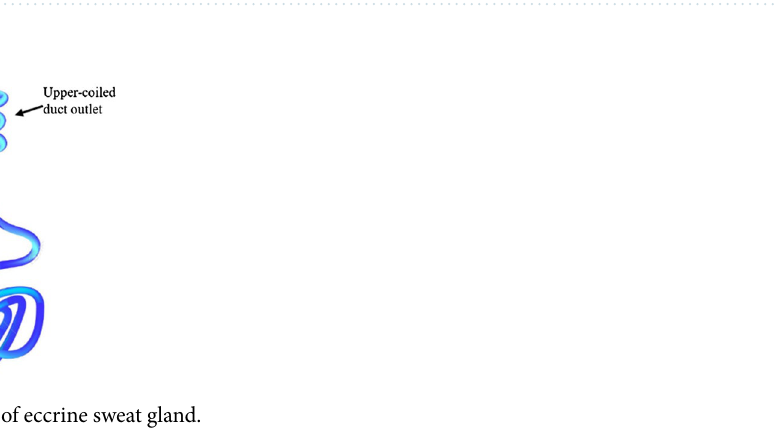
Figure 1. A schematic of human skin showing the main human skin layers and coiled sweat duct. (Modified from the original under a CC BY SA license, https:// creat iveco mmons. org/ licen ses/ by- sa/4. 0/. Copyright Guido Hegasy, https:// www. hegasy. de/).